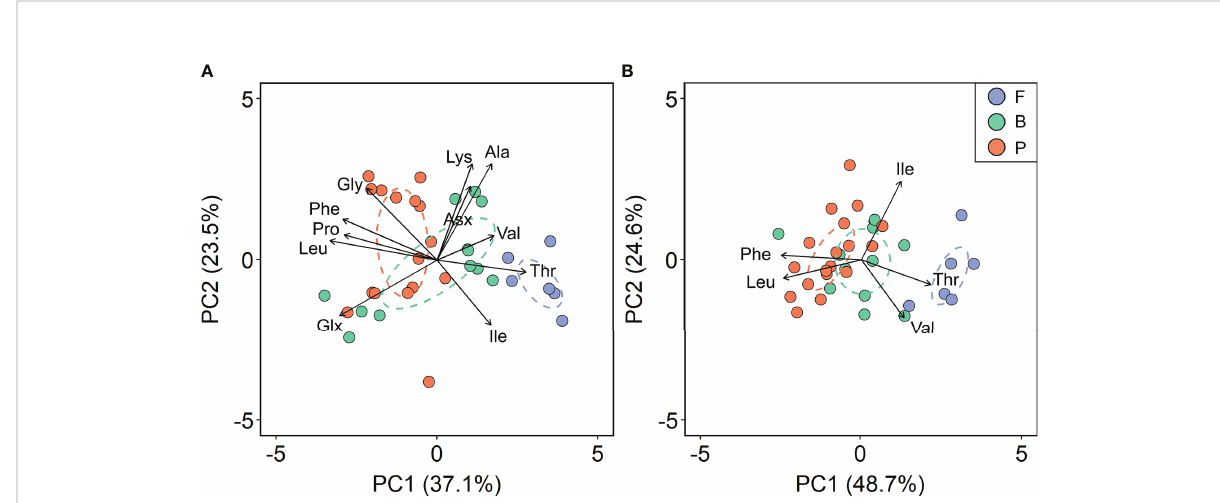
FIGURE 4 Principal component analysis based on normalized d 13 C values of (A) 11 amino acids and (B) fi ve essential amino acids of pelagic algae (P) and sea ice algae from the fast ice (F) and brash ice (B). Values in parentheses of the axis titles are the percentage variation explained by each axis. The colored ellipses represent standard ellipse area (SEA) for each corresponding group, containing ~40% of the